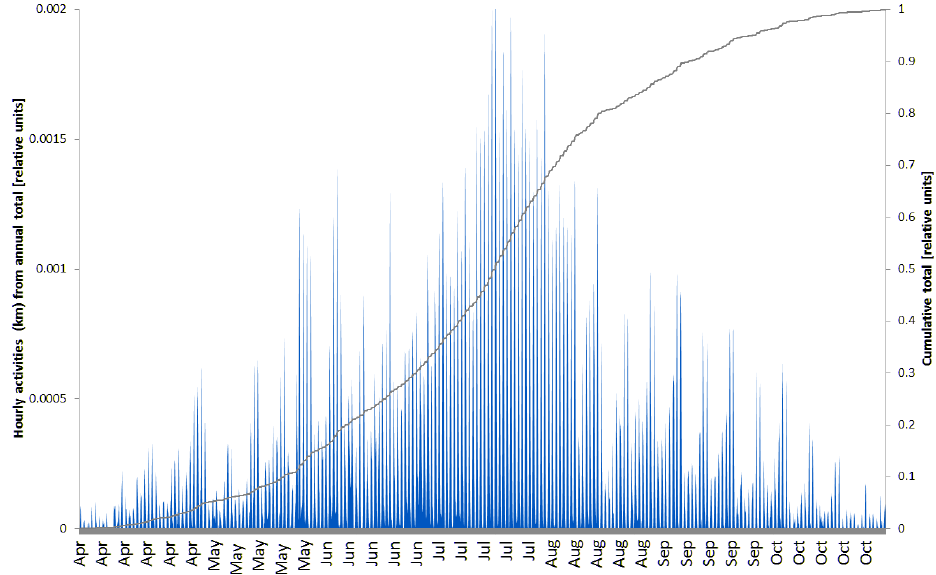
Figure 3. Estimated hourly temporal profile (blue bars) of leisure boat activities in the Baltic Sea based on AIS data and modeled travel distances with STEAM. The secondary vertical axis (right) shows the cumulative temporal profile (gray line) as a function of